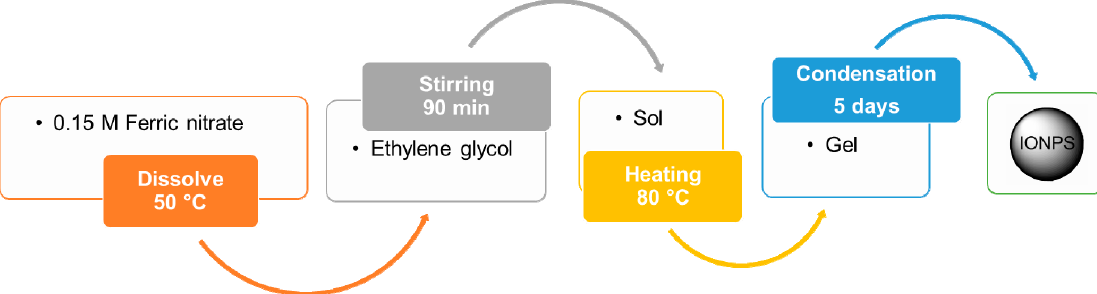
Figure 5. Flowchart for the synthesis of IONPs by sol-gel method [41,42]. Ferric nitrate is directly dissolved in ethylene glycol at 50 °C. The resulting sol is then dried by heating to get the gel, and finally, the IONPs of interest.